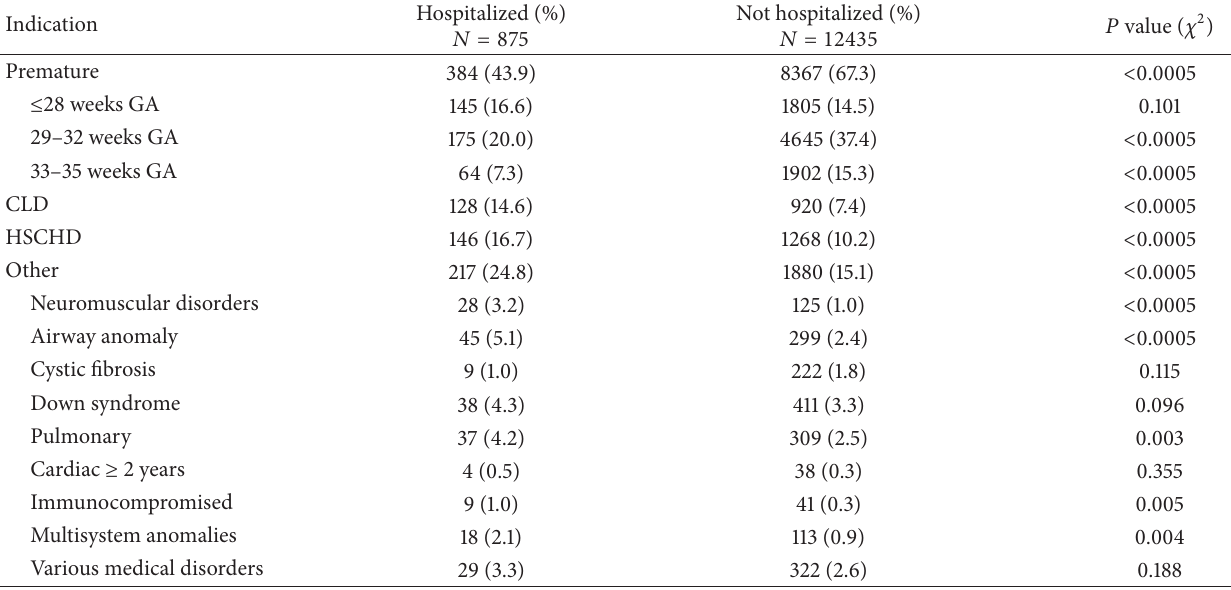
Table 3: Hospitalized versus nonhospitalized patients for respiratory-related illness based on indication.